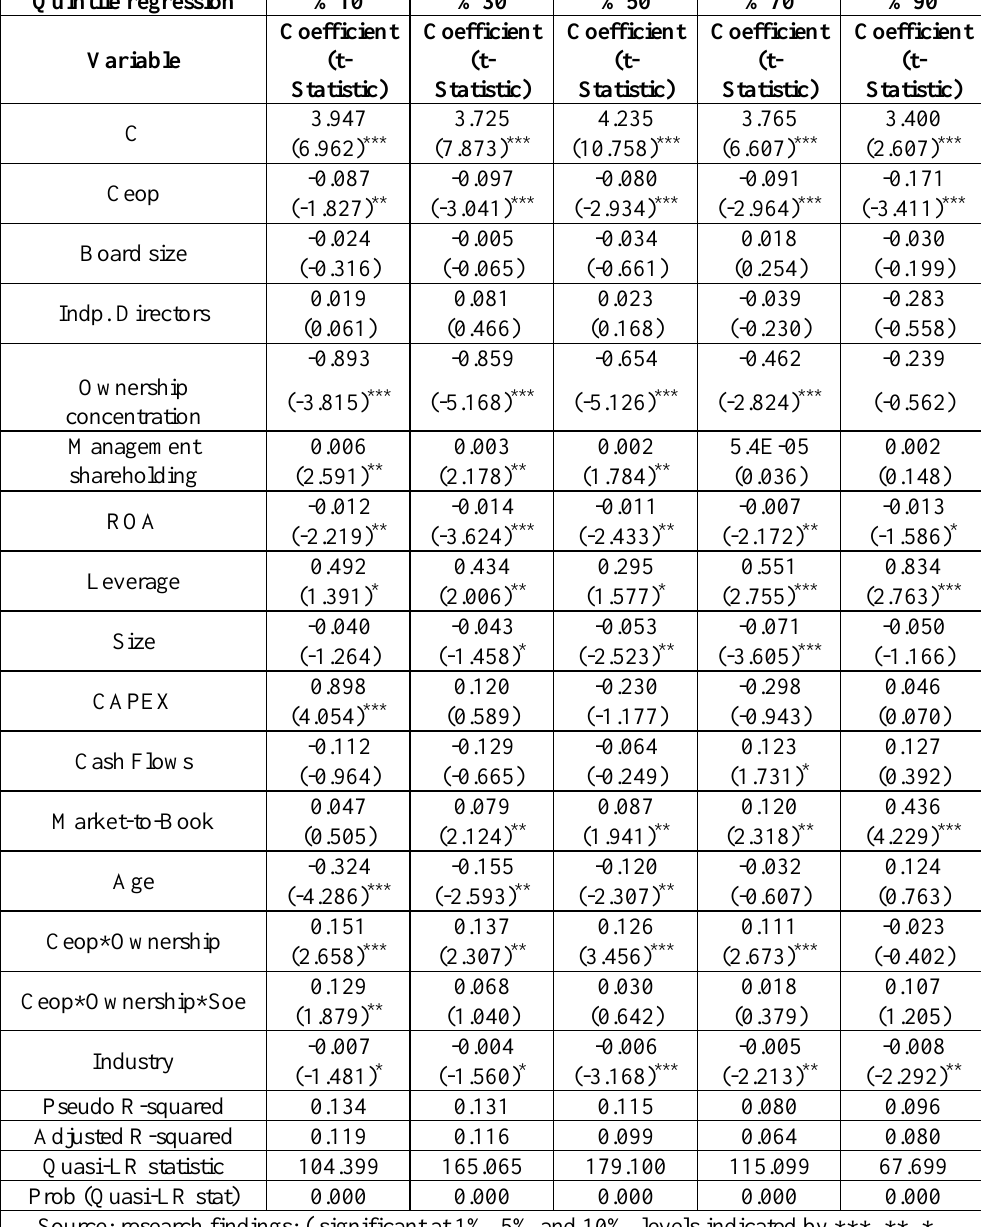
Table 8. fitness results of model 3. (dependent variable: systematic